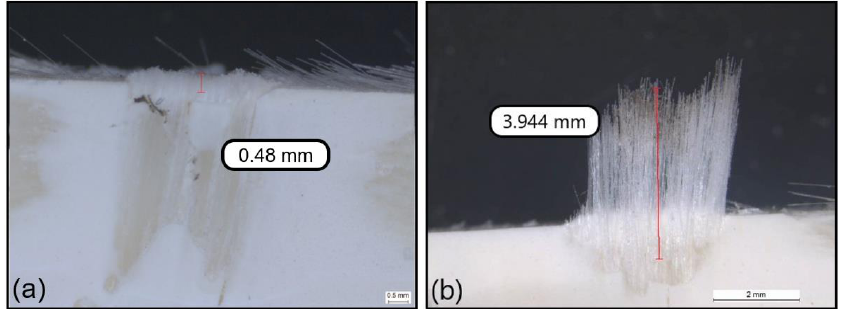
Figure 7. Illustration of the delamination depth: ( a ) type I and ( b ) type I/II caused by T3 at the fresh state.